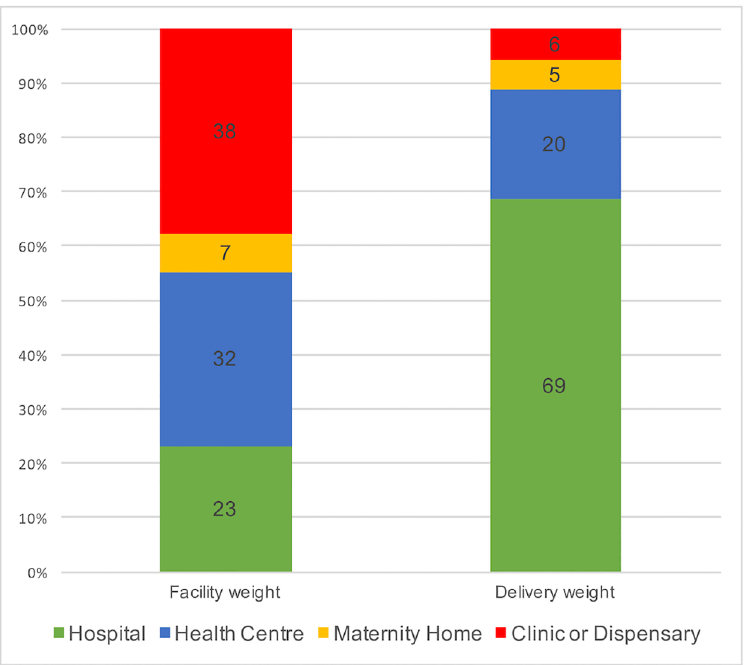
Fig 4. Re-calibrating our measurements: Percentage of facilities in each category vs. percentage of births that occurred in each type of facility (delivery caseload weight).